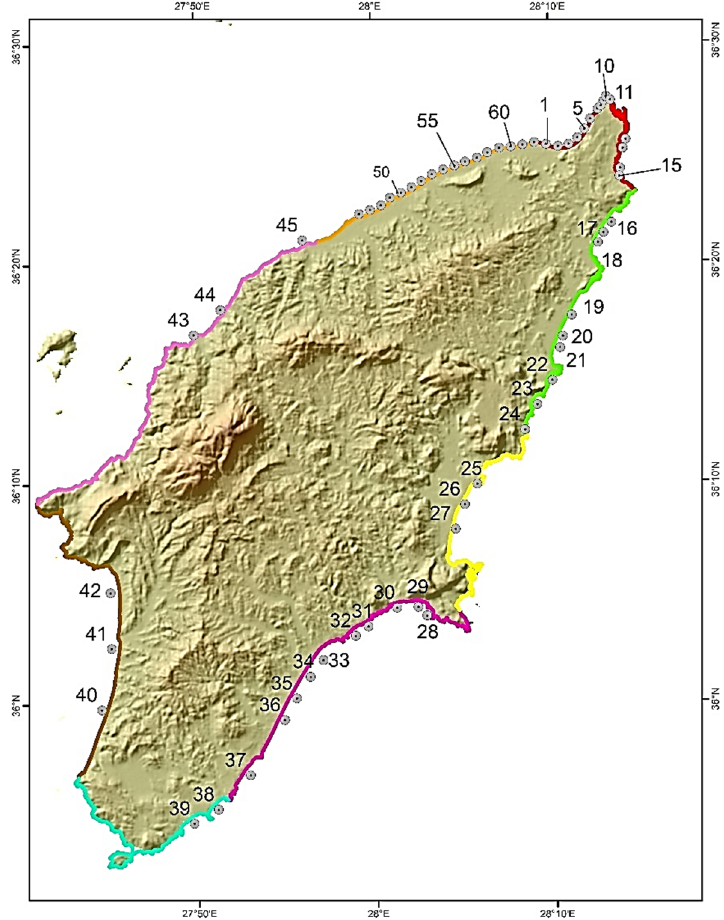
Figure 7. Locations of cross-shore profiles along the island.